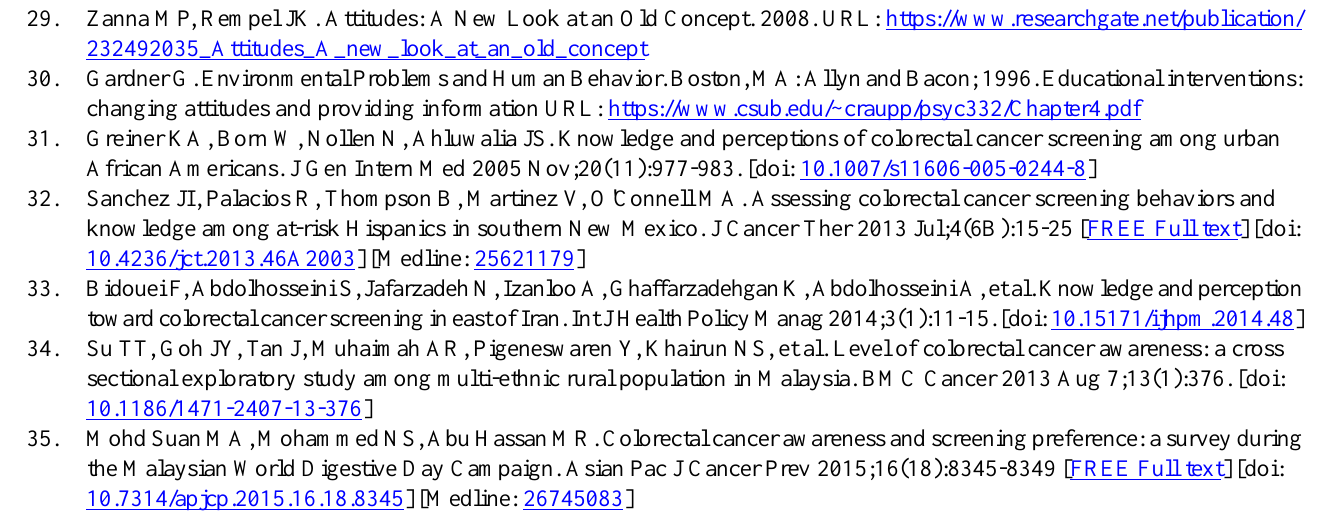
ANCOVA: analysis of